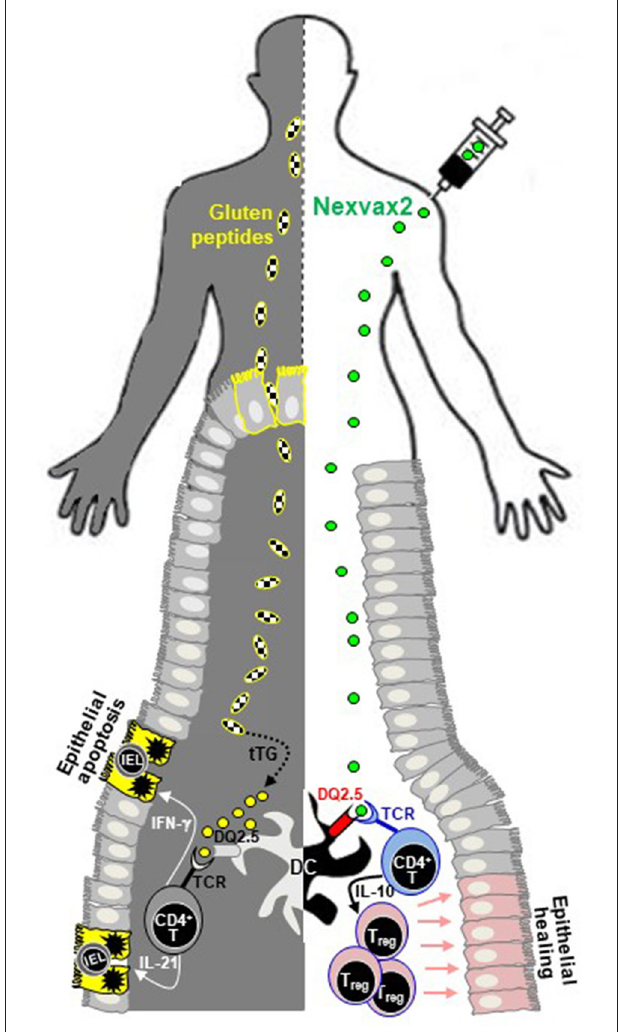
FIGURE 1 | Schematic representation of Nexvax2 mechanism of action in patients with celiac disease. Nexvax2 is an epitope-specific vaccine that contains five different immunodominant gluten peptides. In patients suffering from celiac disease, the ingested gluten (left-hand side) is deamidated by tissue transglutaminase, a process that enhances its immunogenicity and eases recognition by HLA molecules expressed on dendritic cells. The subsequent increased production of pro-inflammatory cytokines by CD4 + T-cells is responsible for the small bowel mucosal damage, including villous atrophy and intraepithelial lymphocytosis. After Nexvax2 injection (right-hand side), peptides are recognized by HLA-DQ2.5, expressed on the surface of dendritic cells, and by the T-cell receptor of CD4 + T-cells, with subsequent increased production of interleukin-10. The repeated exposure to these peptides is thought to restore a normal tolerance toward gluten, thus healing the deranged small bowel mucosa of patients with celiac disease. DC, dendritic cell; IL, interleukin; IEL, intraepithelial lymphocyte; IFN, interferon; TCR, T-cell receptor; tTG, tissue